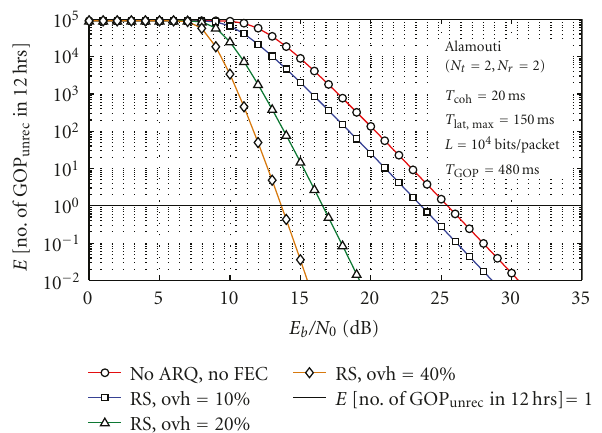
Figure 17: Average number of GOPs a ff ected by unrecoverable packet loss in 12 hours (Alamouti, N r = 2, RS).